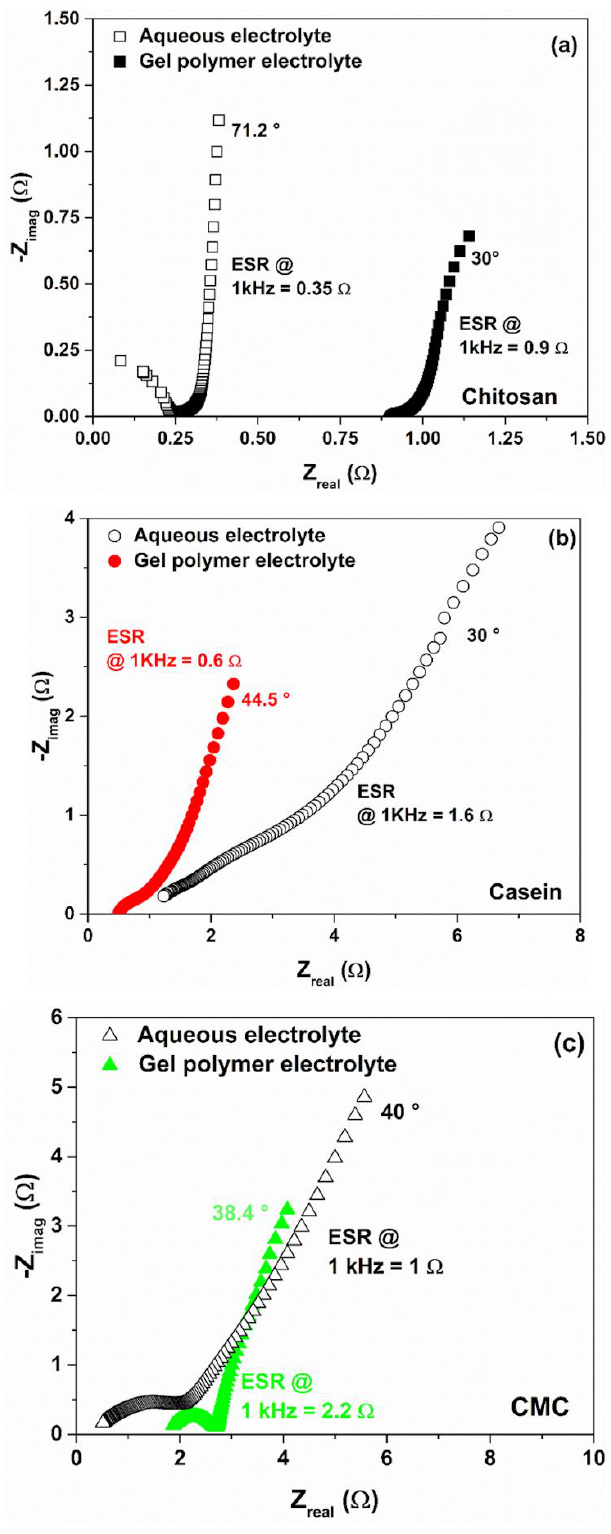
Figure 7. Comparative Nyquist plots for the supercapacitors based on gel polymer and reference liquid electrolytes with ( a ) chitosan, ( b ) casein and ( c ) CMC as an electrode binder.